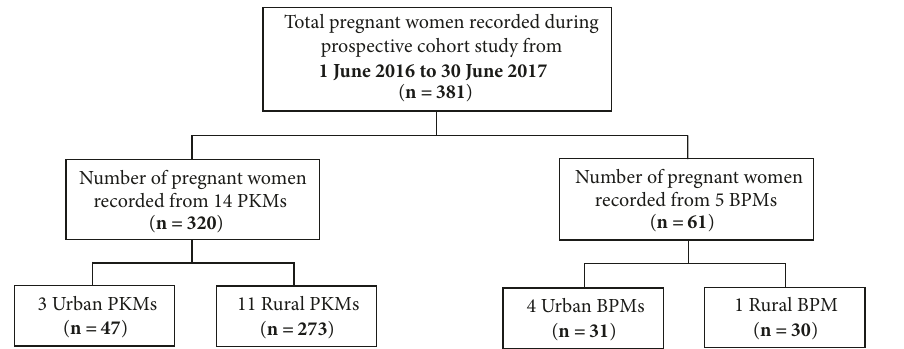
Figure 2: Description of prospective data.